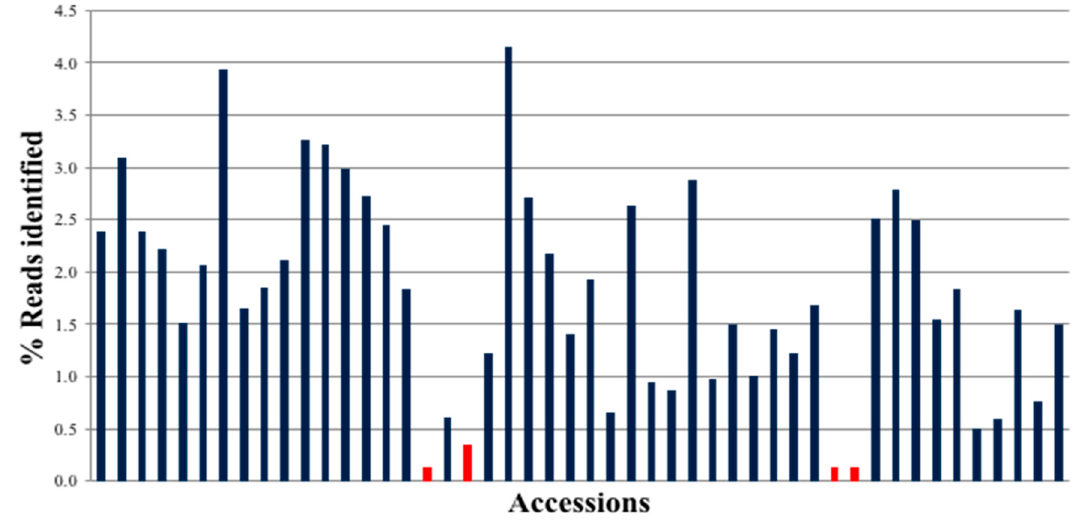
Figure2. MiSeqSequencingRunDistributionofreadsbyPeanutAccessiononMiSeq(250X2)(totalreads: Figure 2. MiSeq Sequencing Run Distribution of reads by Peanut Accession on MiSeq (250X2) (total 30,153,796; PFReads(ReadsthathavepassedIlluminaqualityfilter): 24,430,536)(eachindexcorresponds reads: 30,153,796; PF Reads (Reads that have passed Illumina quality filter): 24,430,536) (each index to a di ff erent plant accession, given in Supplemental Table S5). Red bars indicate the accessions that corresponds to a different plant accession, given in Supplemental Table S5). Red bars indicate the failed to amplify accessions that failed to amplify satisfactorily.